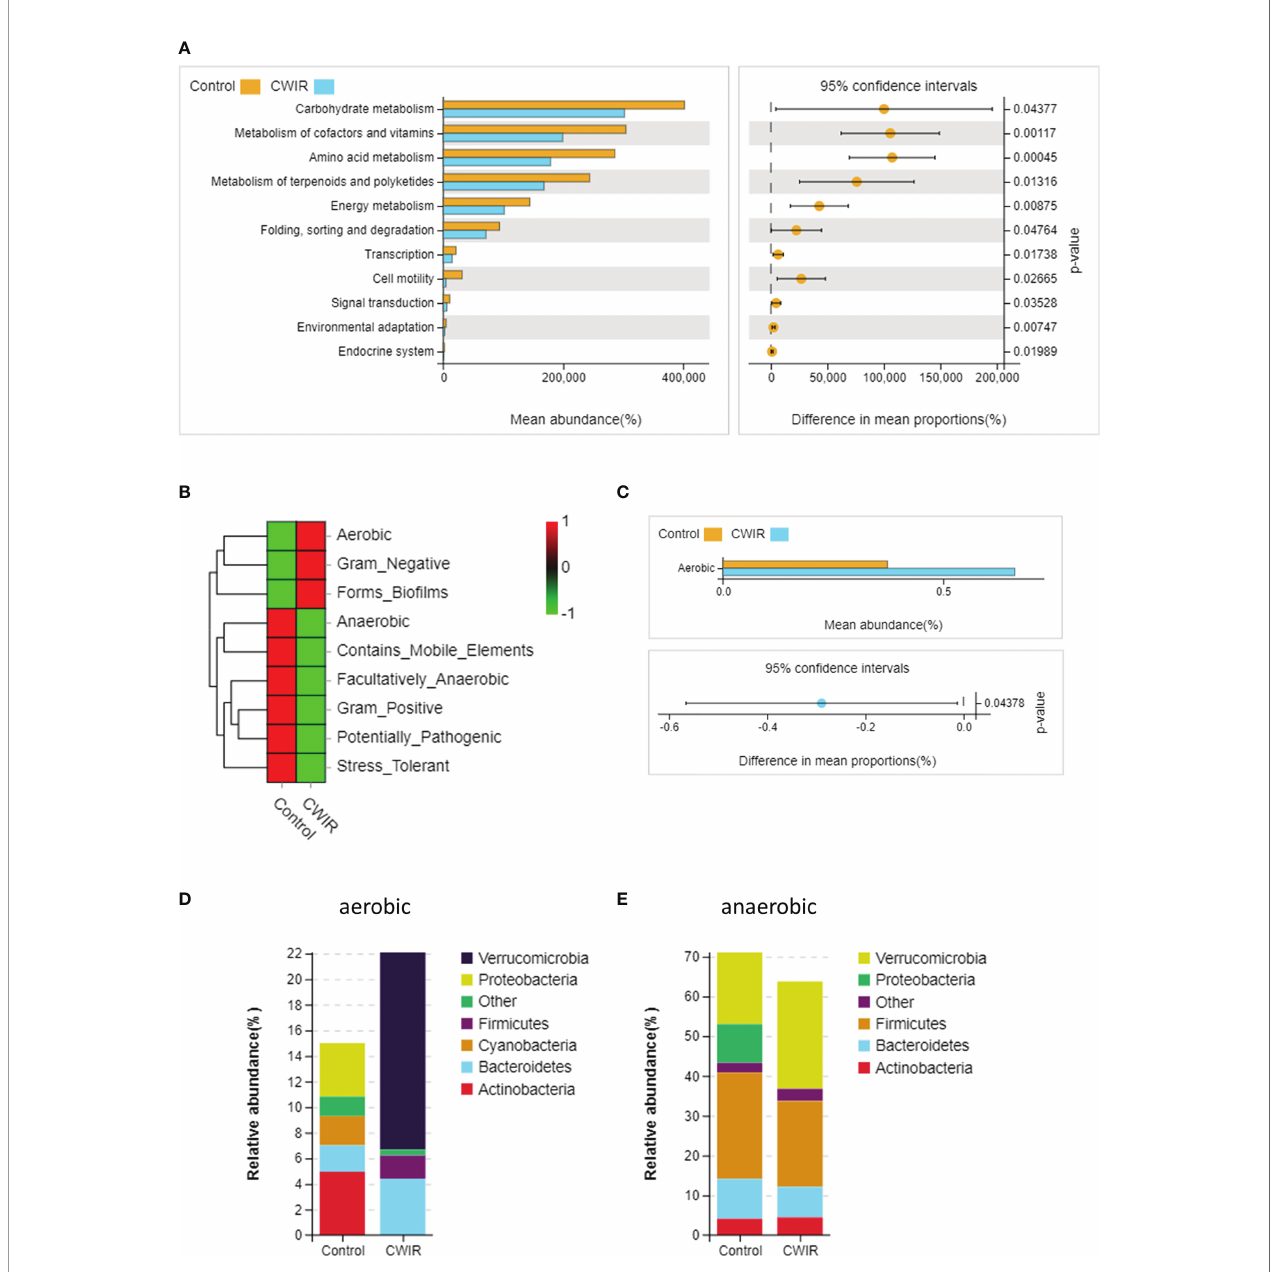
FIGURE 6 | The functional capacities were predicted based on 16S data using PICRUSt2 and BugBase. (A) PICRUSt2 was used to predict the function of gut microbiota at level-2. (B) Heatmap of microbial community phenotypes and the corresponding bacterial contributions (BugBase). (C) Statistical signi fi cance of aerobic microbiota in the two groups was determined by Welch ’ s t-test. (D, E) Relative abundance plots of aerobic and anaerobic bacteria in the control and CWIR samples at the phyla level (BugBase). n = 4 per